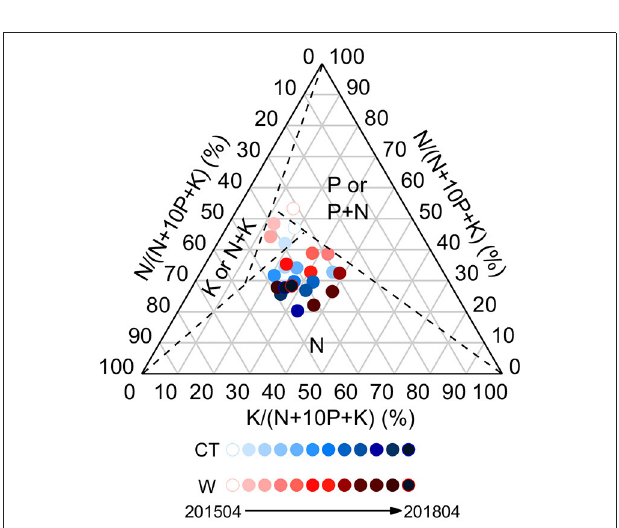
FIGURE 3 | Ternary diagram of nutrient limitation in the leaves of Cunninghamia lanceolata under control and warming treatments.